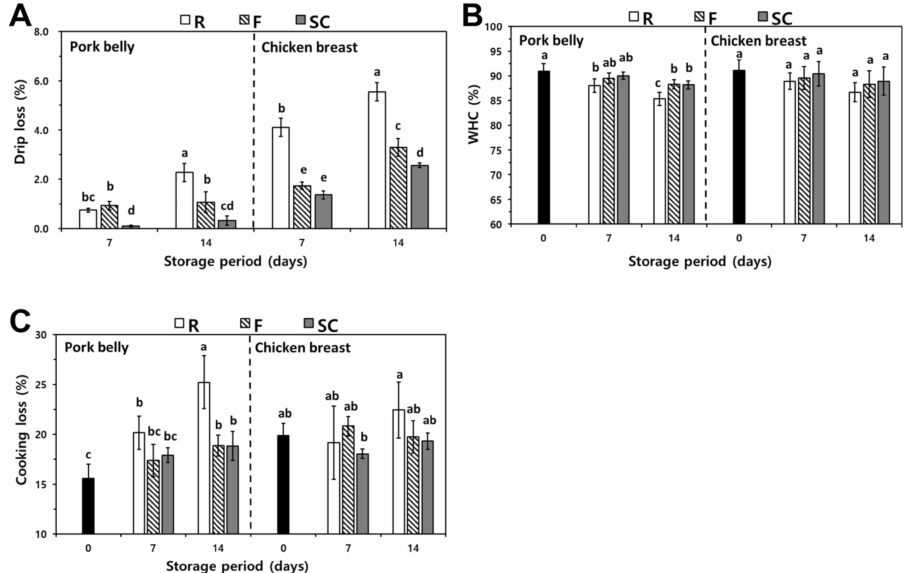
Figure 3. Changes in drip loss ( A ), WHC ( B ), and cooking loss ( C ) of pork belly and chicken breast depending on various storage temperatures and periods. R, Refrigeration; F, Freezing; S, Supercooling. a–e Means with different lowercase letters within the same samples are significantly different ( p < 0.05). Replication of drip loss is three and that of others is